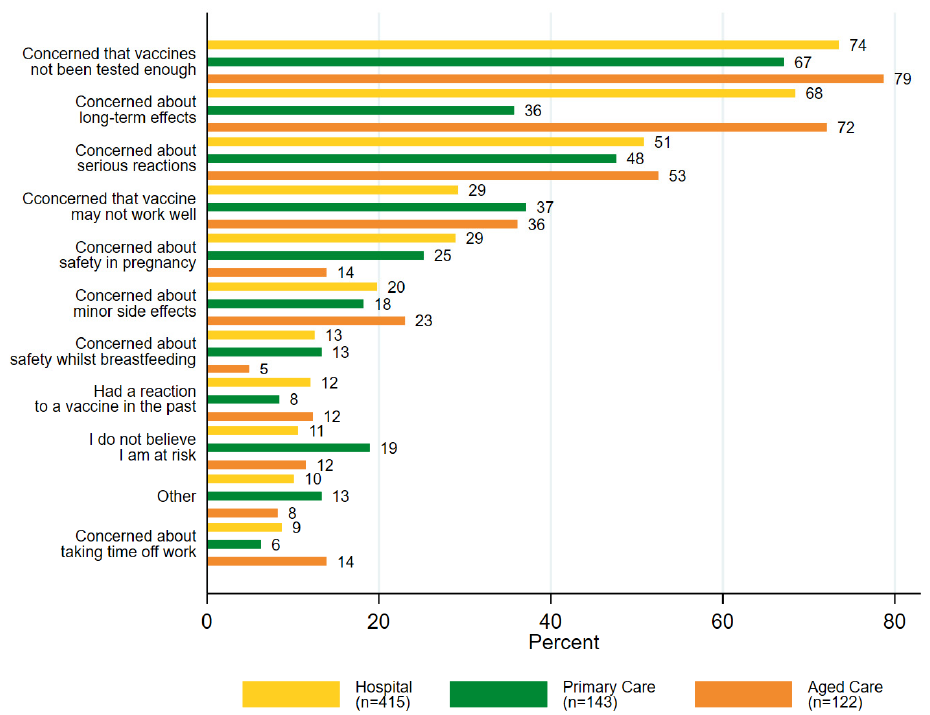
Figure 3. Concerns of HCWs (% selected) who were unsure or did not intend to accept a COVID- 19 vaccine ( n = 680), by